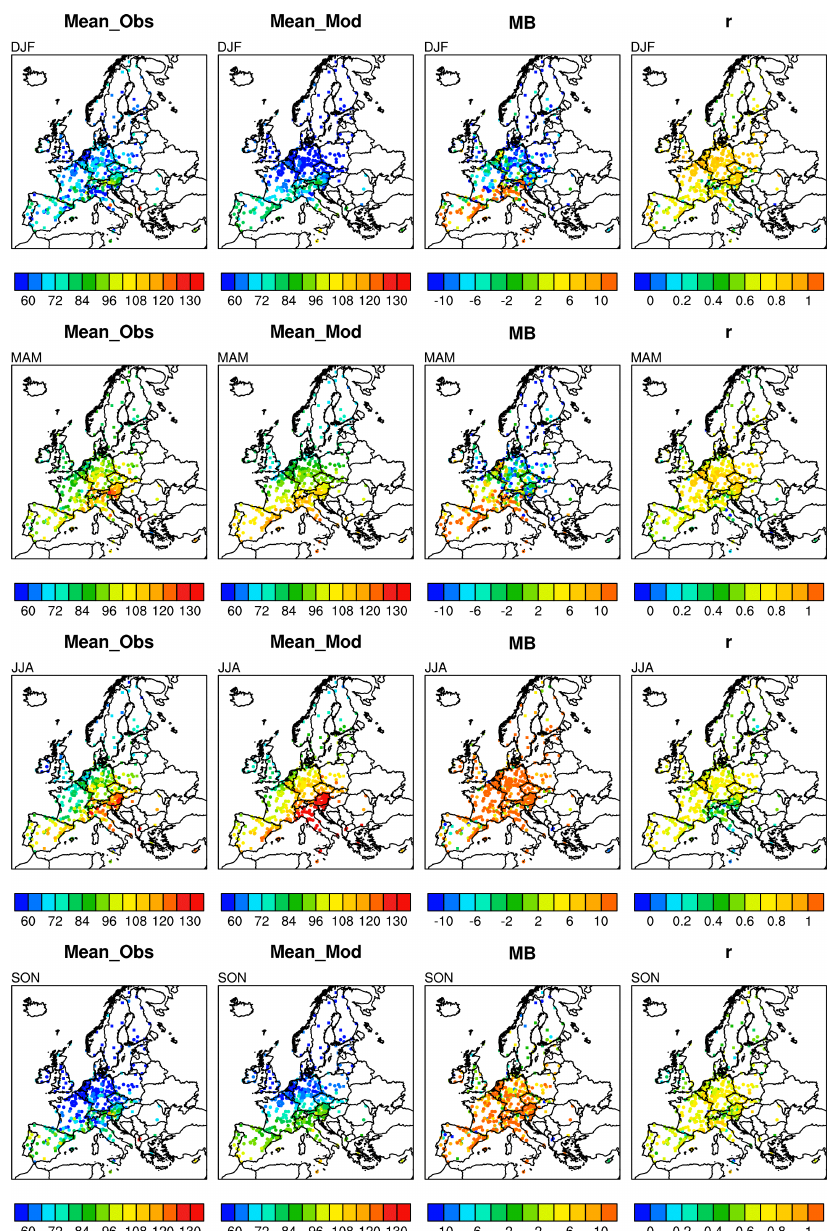
Figure 6. Seasonal average values of MDA8 in µgm − 3 calculated from hourly measurements at AirBase (circles) and EMEP (squares) stations, and modeled values from MOZART for corresponding locations. The MB, in µgm − 3 and temporal correlation coefficient ( r ) for daily values are also shown at the location of station